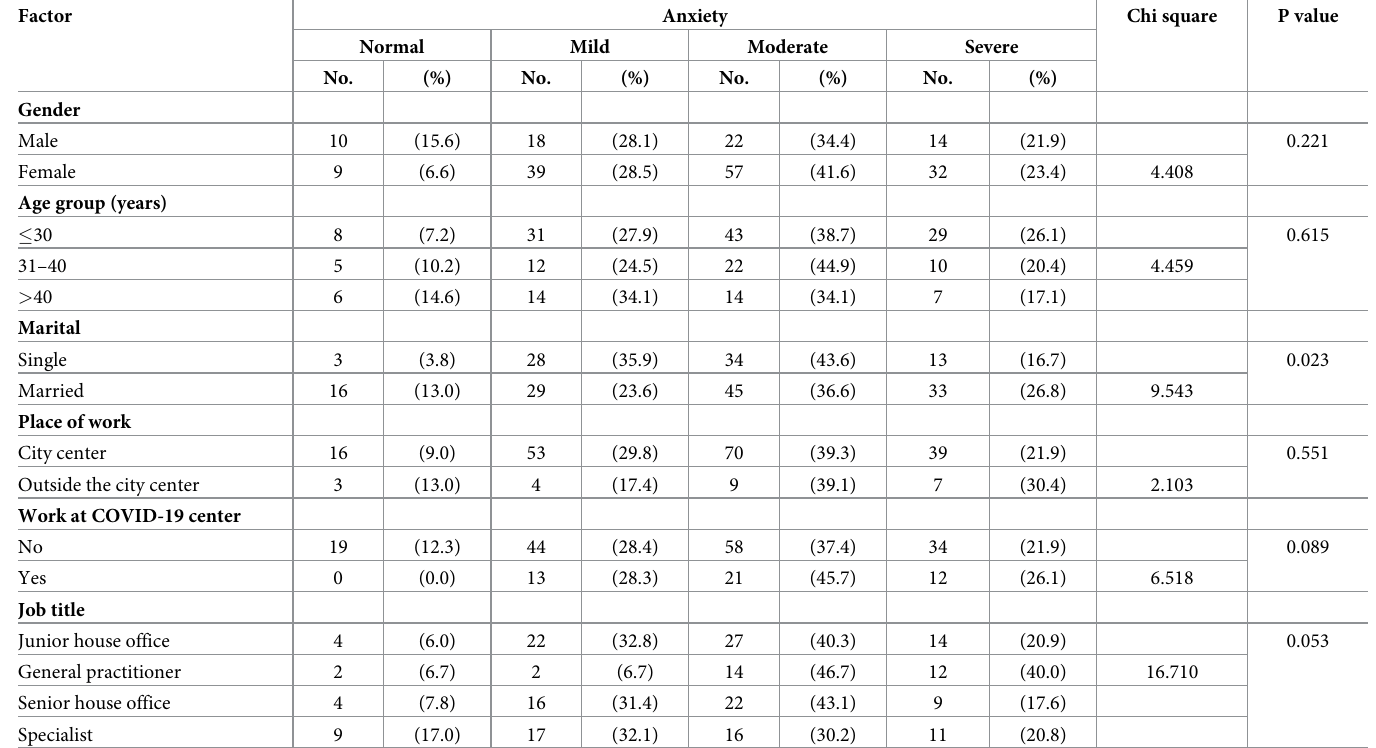
Table 6. Prevalence of different degrees of anxiety according to the demographic and professional characteristics of the participants.